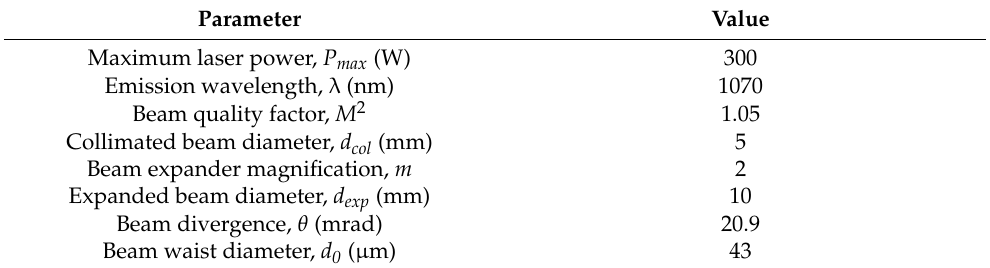
Table 3. Specifications of the laser system employed in the prototypal LPBF system. Parameter Value Maximum laser power, P max (W) 300 Emission wavelength, λ (nm) 1070 Beam quality factor, M 2